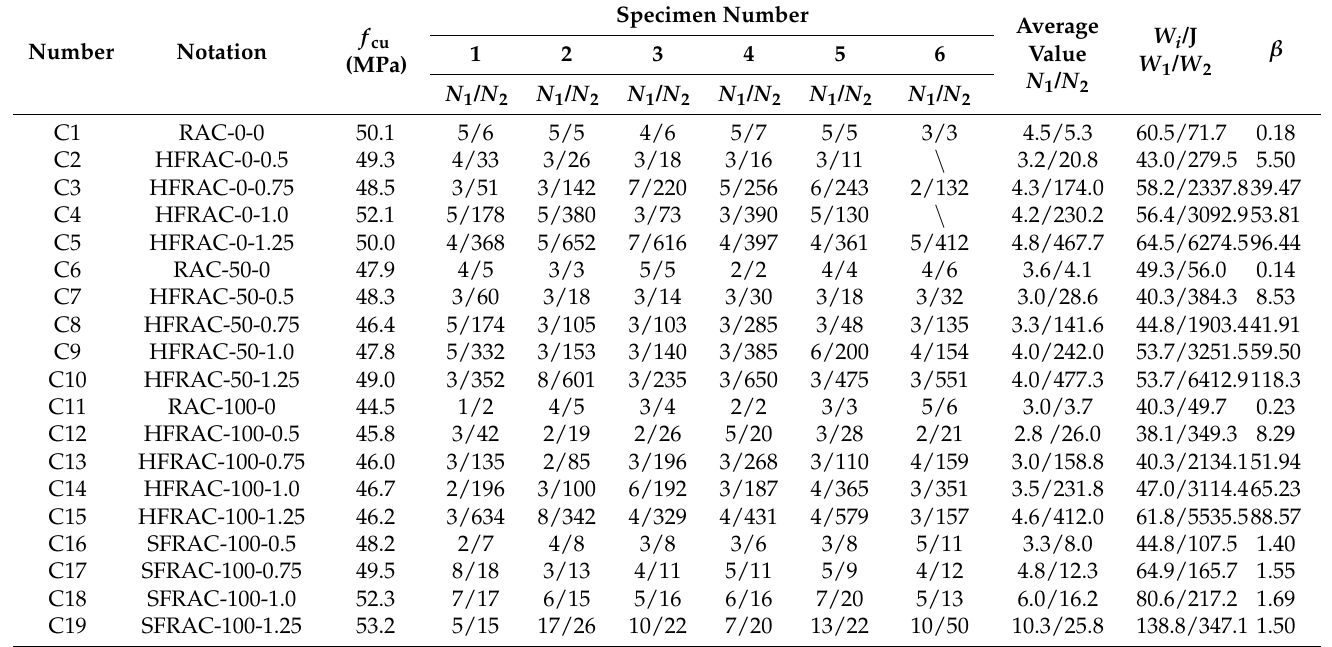
Table 3. Results of compressive strength and impact